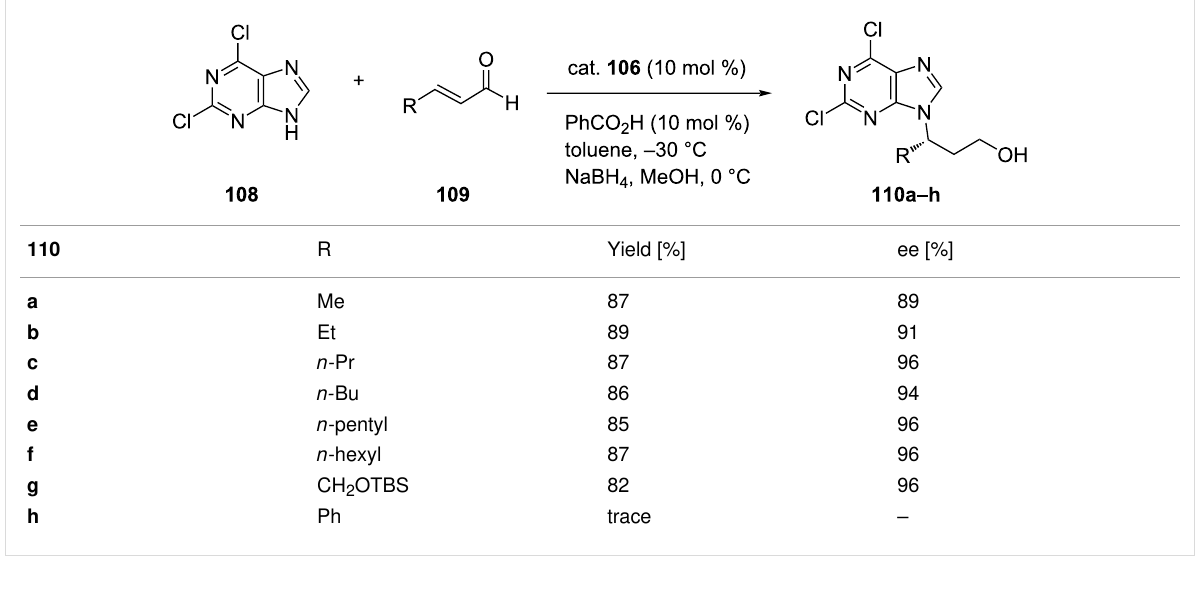
Table 25: Asymmetric aza-Michael addition of purine bases to aliphatic α , β -unsaturated aldehydes.